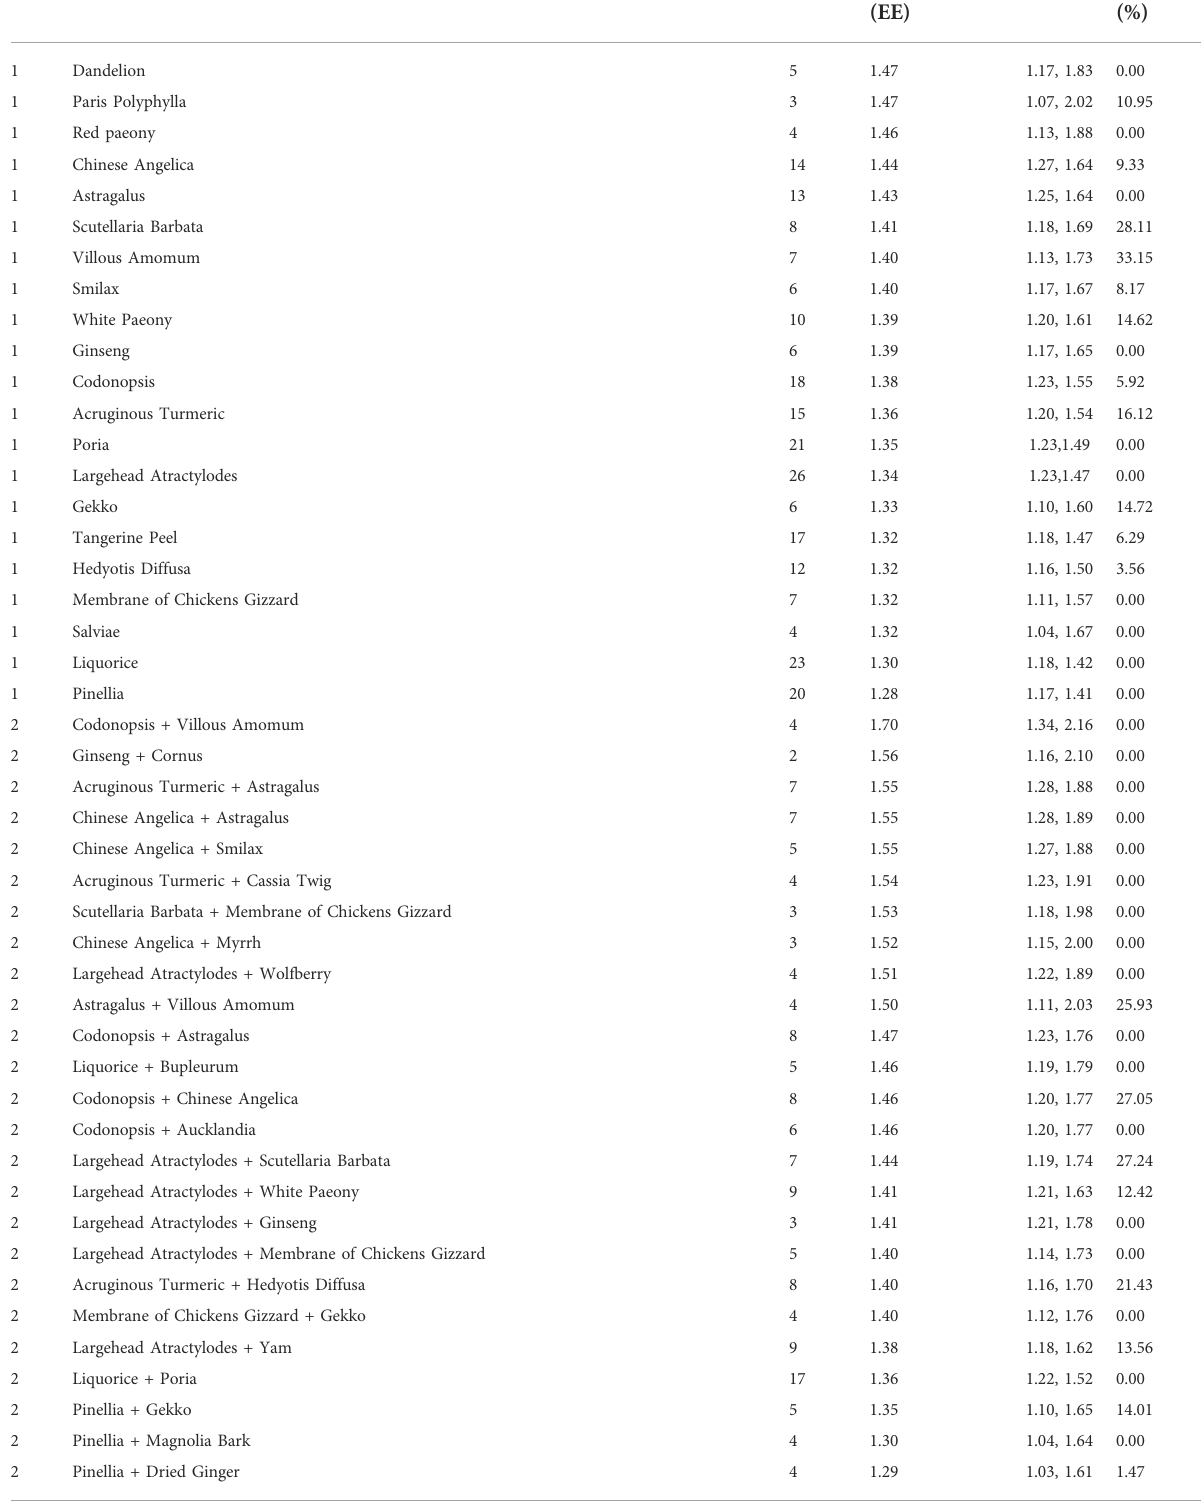
TABLE 4 Sensitivity analysis of speci fi c contributions of